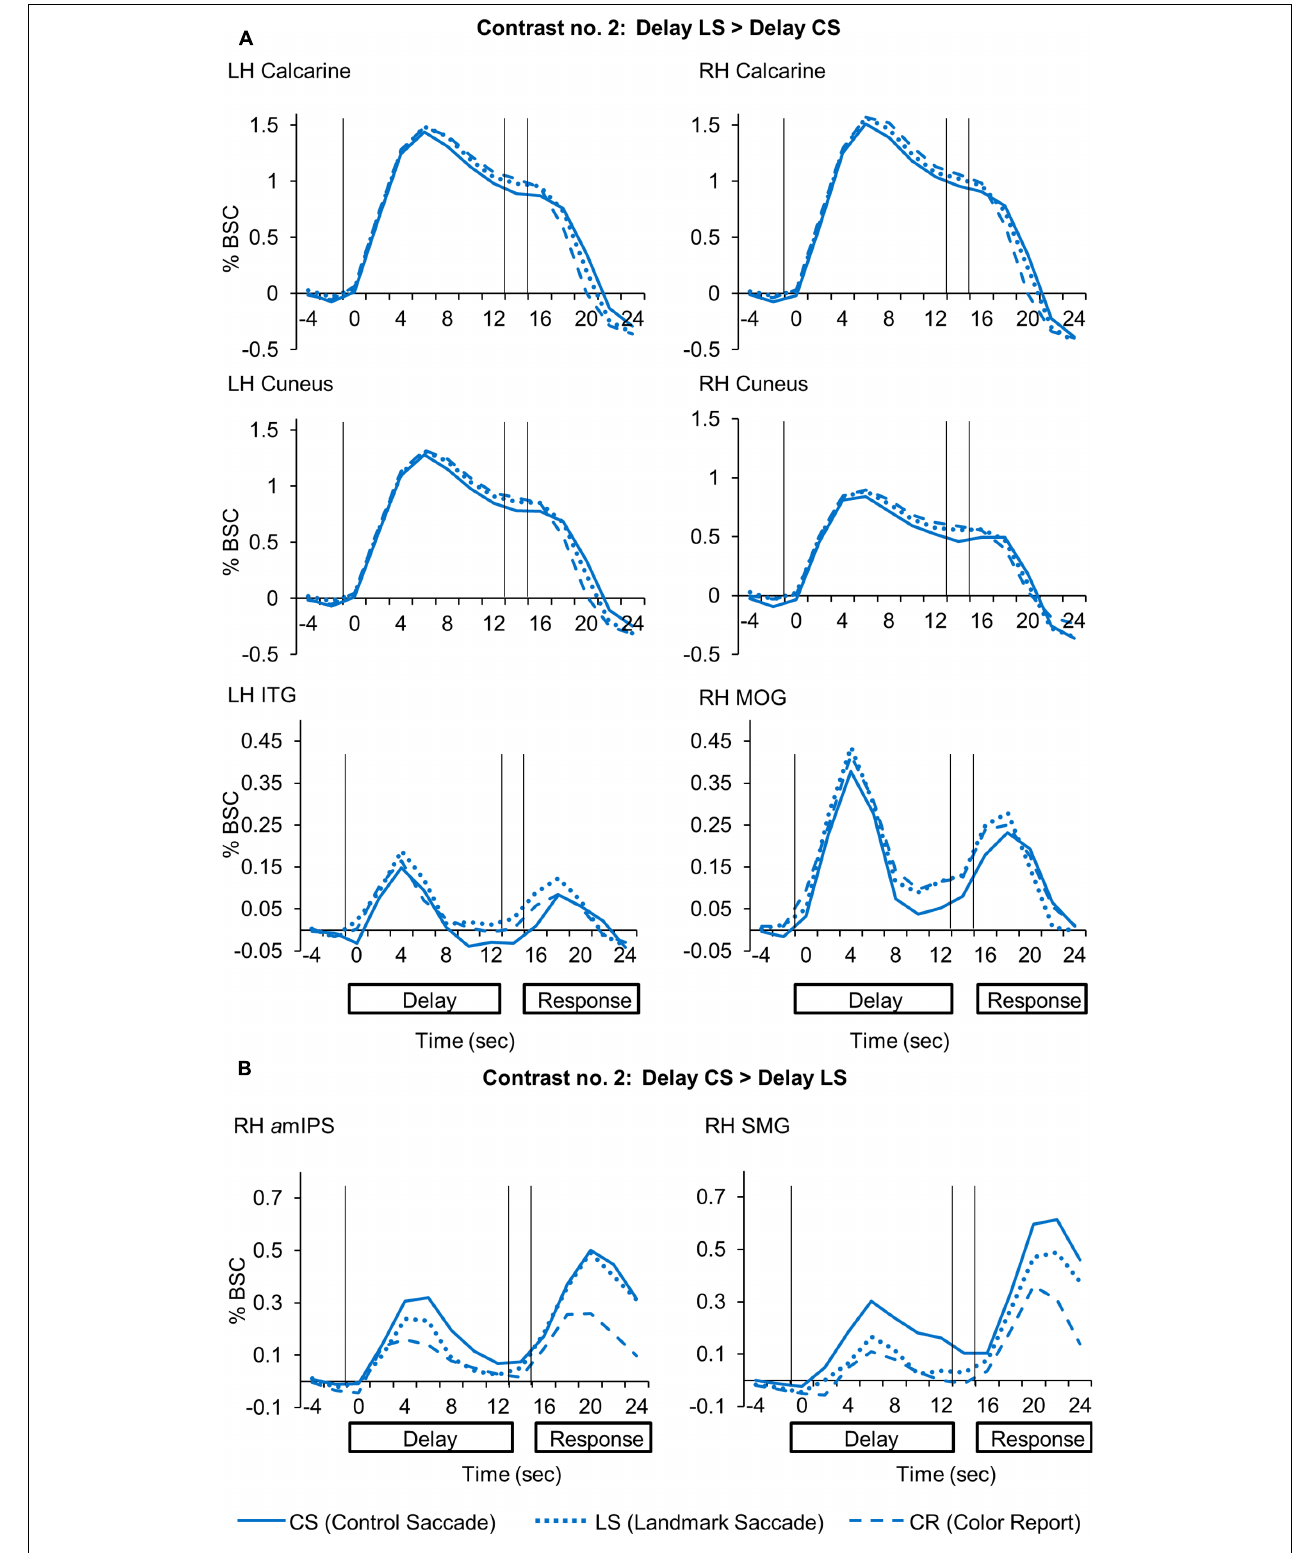
FIGURE 6 | Time course data in line graphs show average % BSC from each of regions identified using Contrast no. 2. (A) [Delay LS > Delay CS]. (B) [Delay CS > Delay LS].